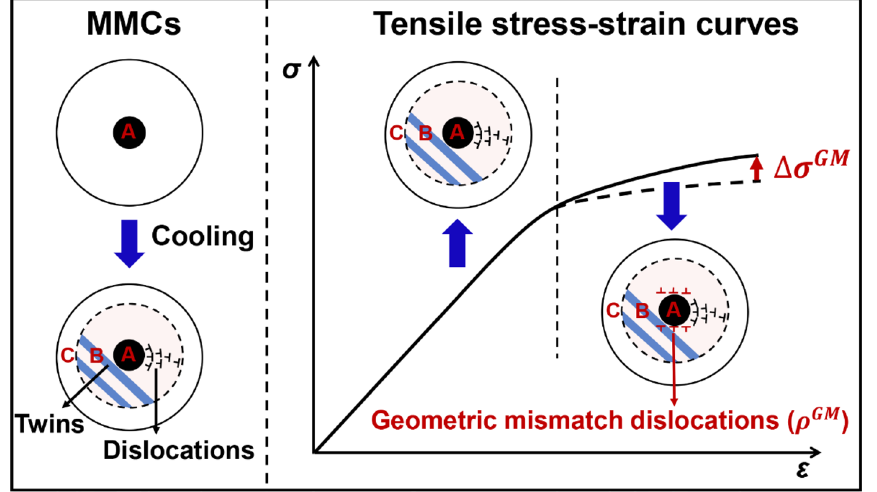
Figure 2. Schematic diagram showing the mechanical property of MMCs with pre-existed thermal mismatch defects. The pre-existed thermal mismatch dislocations or nanoscale twins would appear in MMCs after the cooling fabrication process. The typical grain of MMCs is comprised of reinforcement particles (region A), affected region (region B), and non-affected region (region C). The yield strength of MMCs is determined by the pre-existed defect distribution, type, and volume fraction. The flow stress during the plastic deformation is mainly influenced by the geometric mismatch dislocations ( ρ GM ) that generated near the reinforcement/ matrix heterogeneous